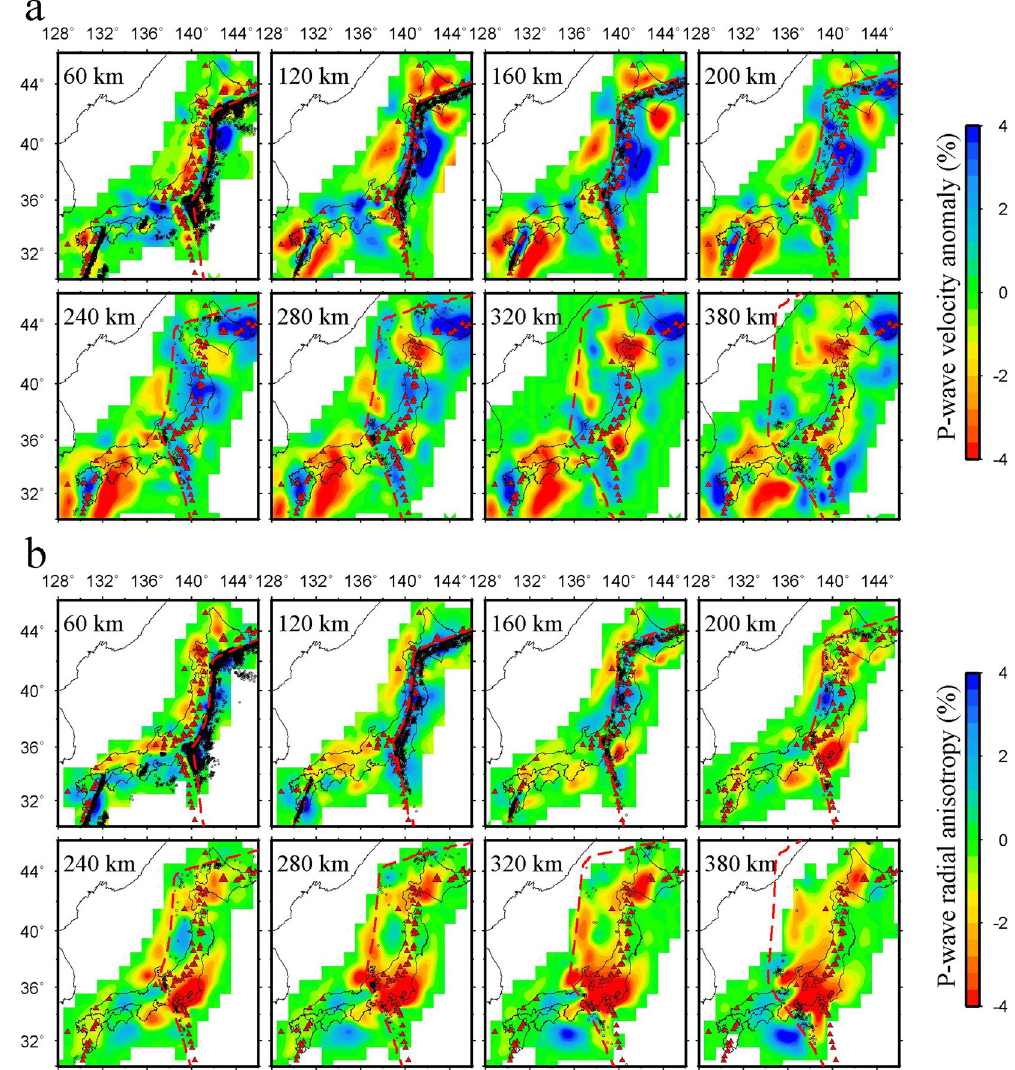
Figure 2. Tomographic images at selected depths beneath Japan. ( a ) Isotropic P-wave velocity images. The red and blue colors denote low and high velocities, respectively. ( b ) Images of P-wave radial anisotropy. The red and blue colors denote negative and positive radial anisotropies, respectively. The scales for the isotropic Vp anomaly and radial anisotropy amplitude are shown on the right. A 3-D grid with a grid interval of 0.5° in latitude, 0.4° in longitude and at depths of 8, 20, 40, 60, 80, 120, 160, 200, 240, 280, 320, and 380 km is set up in the study region for the tomographic inversion. The red dashed line in each map denotes the location of the upper boundary of the subducting Pacific slab at each depth 37, 38 . The red triangles denote active arc volcanoes. The black dots denote the seismicity during a period of 2002–2007 that occurred within a 10 km depth of each layer. This Figure is generated using GMT 4.5.3 (http://www.soest.hawaii.edu/gmt/) developed by Wessel and Smith 59